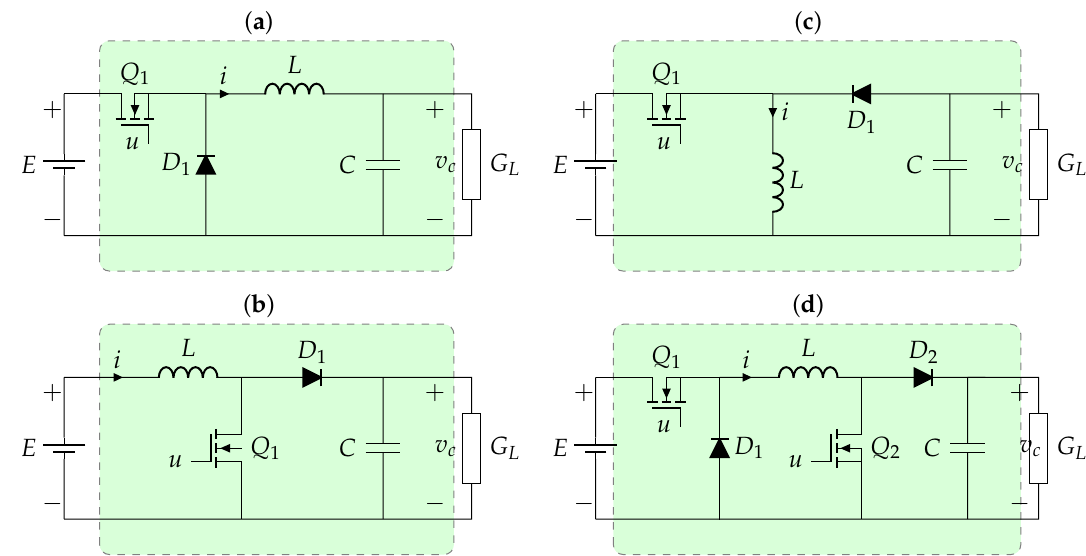
Figure 1. Second-order DC-DC converters: ( a ) buck converter, ( b ) boost converter, ( c ) buck-boost converter, ( d ) non-inverting buck-boost